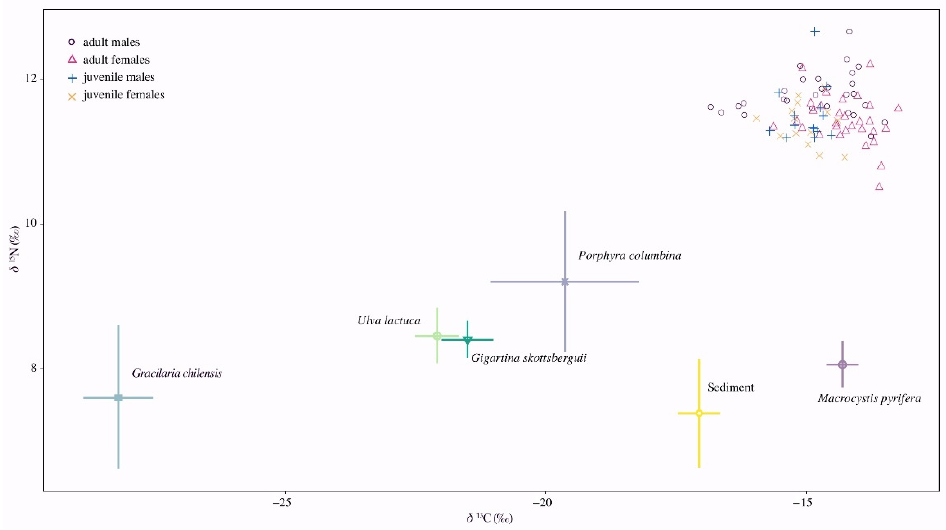
Figure 2. Isotope plot of mean δ 13 C and δ 15 N values (mean ± SD) for basal organic sources and southern king crab Lithodes santolla among sex and maturity stages, Nassau Bay, Cape Horn. Among maturity stages, the mean δ 13 C value of the late juveniles ( − 15.3‰) was significantly lower than in adults (mean − 14.7‰) (Pseudo- F = 12.39; p = 0.001). The mean δ 15 N value of adults (11.6‰) was significantly more enriched 15 N than the late juveniles (mean 11.4‰) (Pseudo- F = 4.67; p = 0.0355). Among sexes, the mean δ 13 C value of the males ( − 15.1‰) was more 13 C depleted than the females (mean − 14.8‰) but there were not significant differences (Pseudo- F = 3.39; p = 0.0509). The mean δ 15 N value of males (11.7‰) was significantly higher compared to the females (mean 11.4‰) (Pseudo- F = 17.62; p = 0.0001). Pairwise comparisons in δ 13 C values among maturity stages and sexes revealed signif- icant mean differences between adult females and late juvenile males, and between adult females and late juvenile females ( p < 0.05). In δ 15 N values, adult males were significantly different in relation to all the other groups ( p < 0.05).